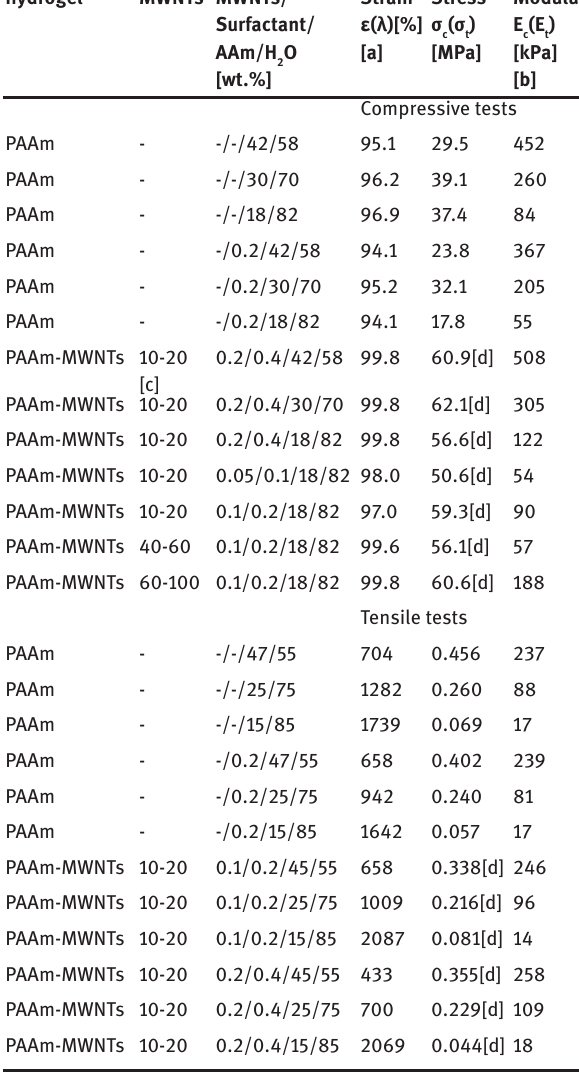
Table 1: The composition of the raw materials, and the compressive and tensile properties of the